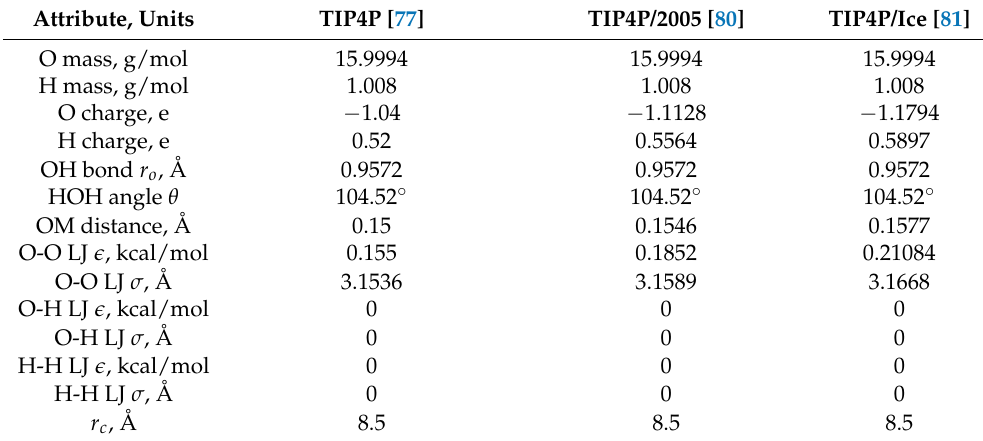
Table 1. LAMMPS force field parameters for various OPLS-AA water